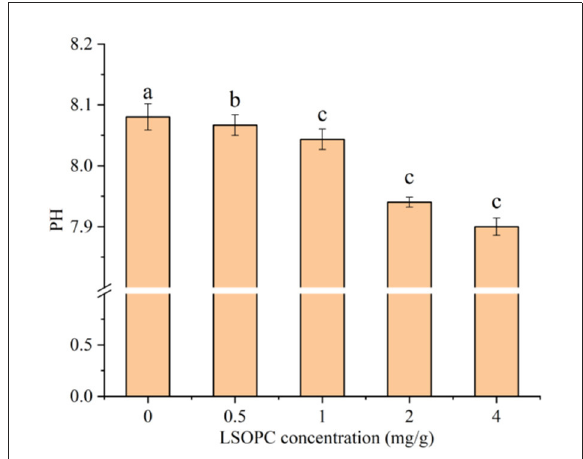
FIGURE6 PH of different concentrations. Significant differences ( p < 0.05 ) of data values were indicated by different letters.